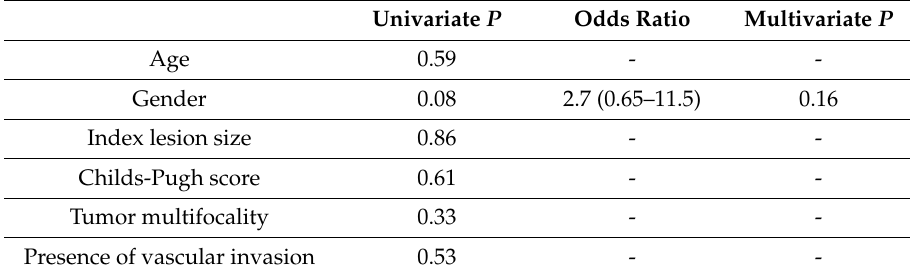
Table 2. Univariate and multivariate analysis of demographic and imaging covariates for immediate objective response (OR). On multivariate analysis, apparent diffusion coefficient (ADC) was the only covariate identified that correlated with